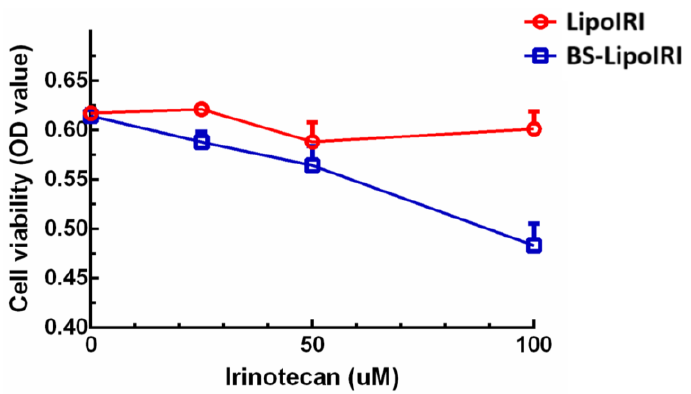
Figure 5. In vitro cytotoxicity of LipoIRI and BS − LipoIRI for BxPC3 pancreatic tumor cells.